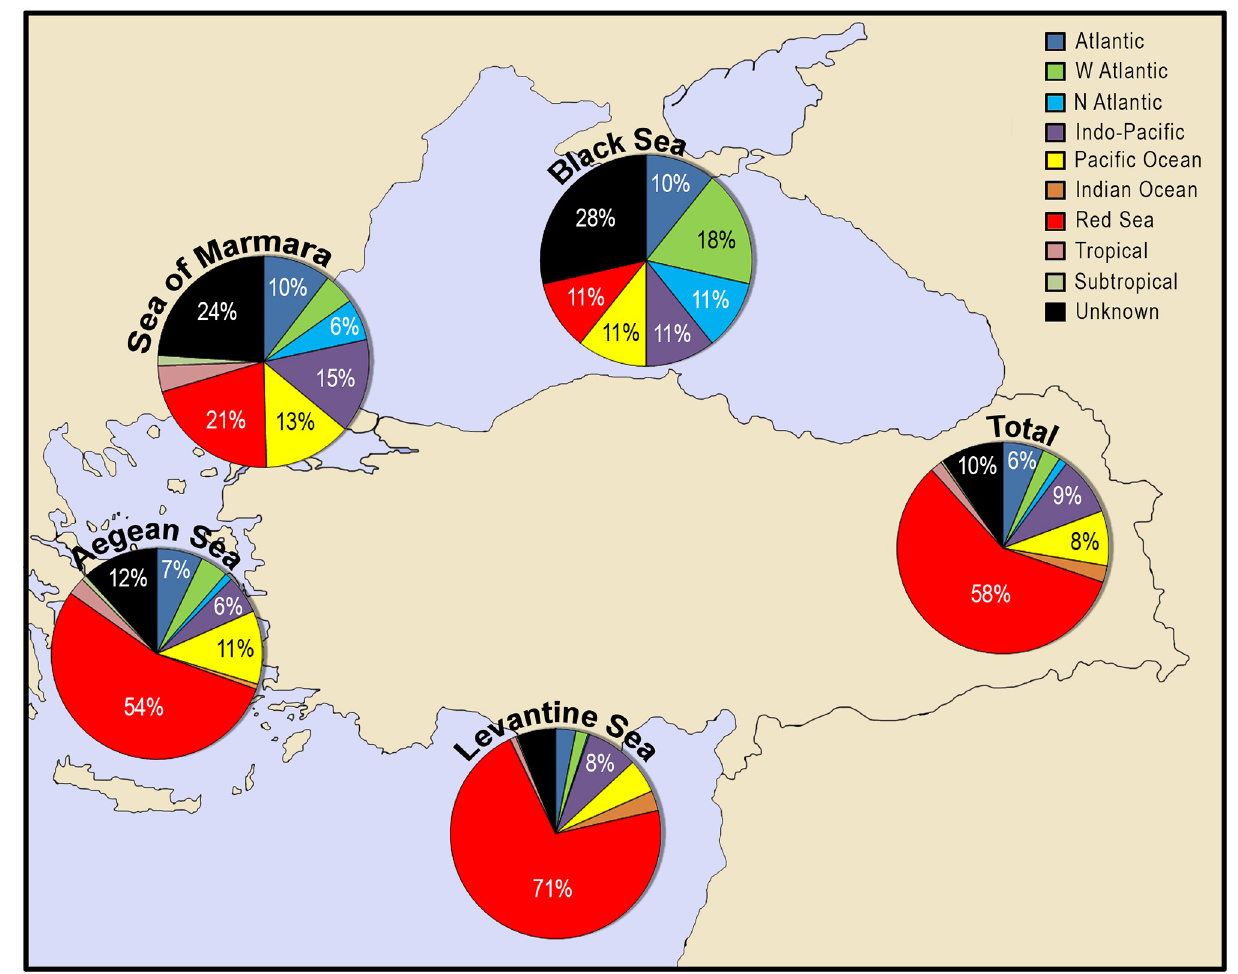
Fig 11. The origins of alien species reported along the coasts of